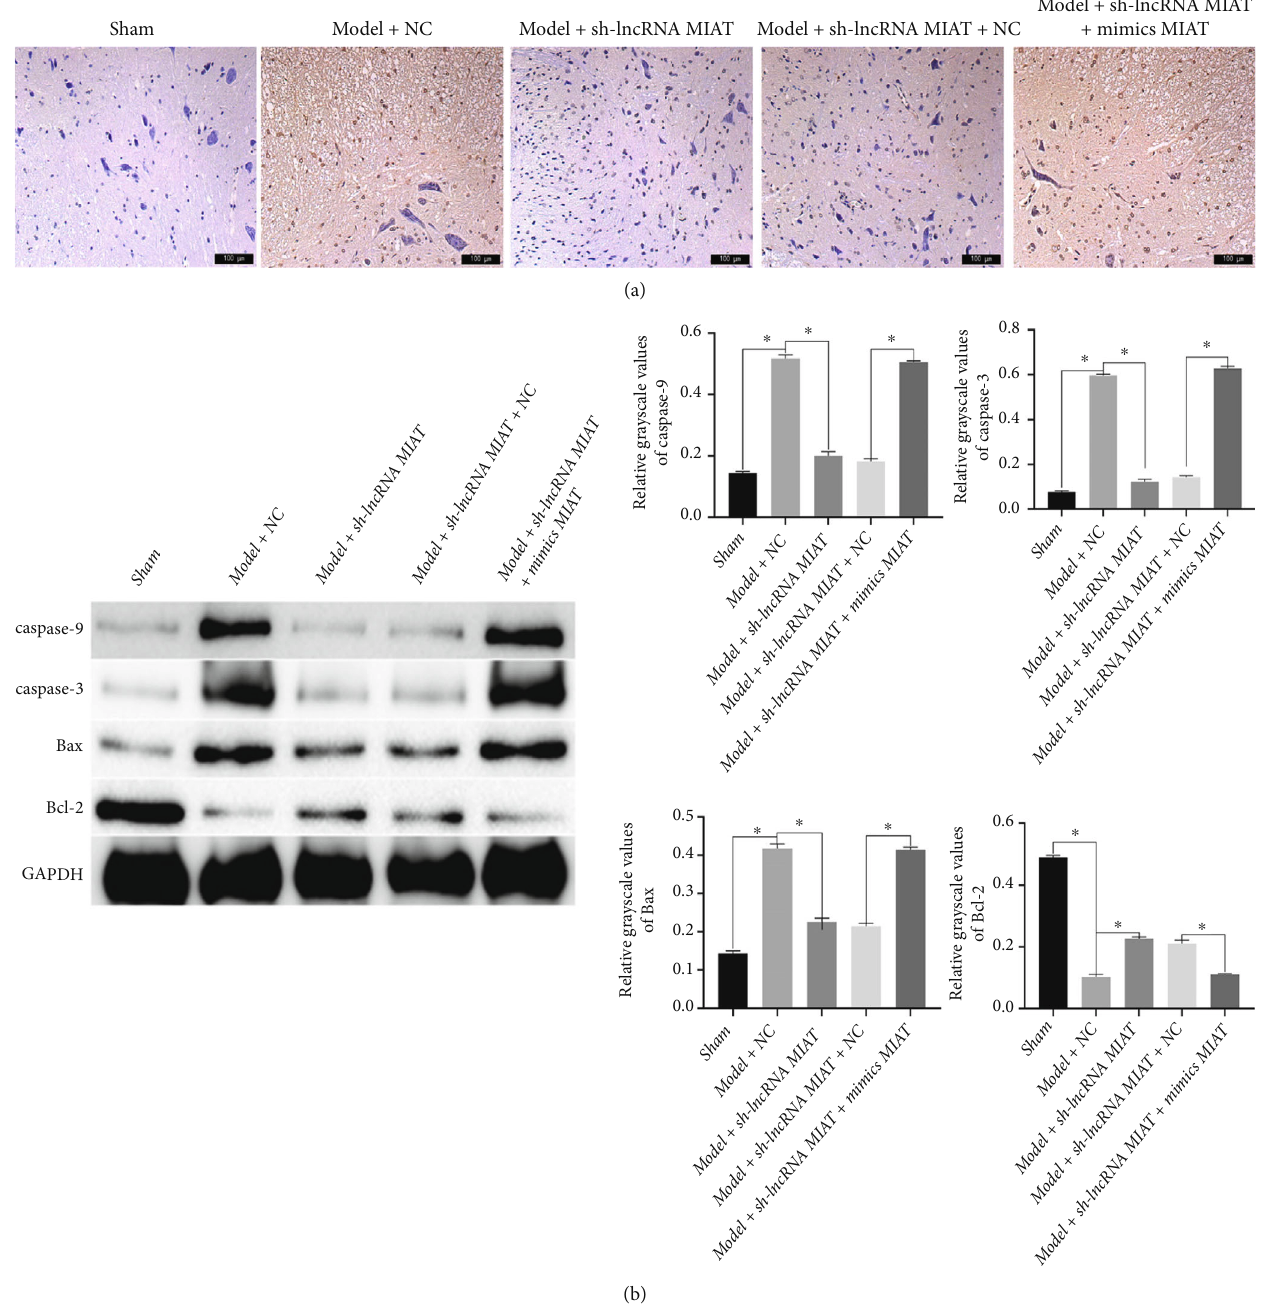
Figure 6: Knockdown of the lncRNA and MIAT was veri fi ed via rescue experiments. (a) Apoptosis detection via TUNEL staining. (b) Detection of changes in apoptosis-associated proteins based on western